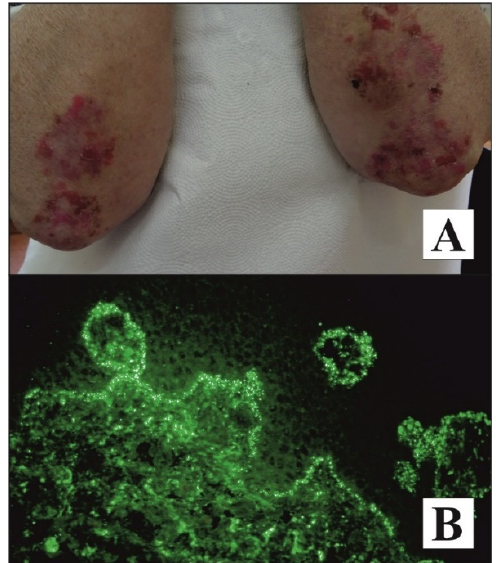
Figure 1. Noteworthy patients with DH. A pruritic, symmetrical rash composed of evolutionary lesions or blisters on an erythematous base located mainly on 1/3 proximal extensor surface of forearms in an elderly woman, having a daughter with mutilating rheumatoid arthritis, with DH developed after vaccination against influenza who showed an elevated level of anti-tTG IgA with ELISA and positive result of b-aIB for anti-npG IgA ( A ). Microgranular IgA deposits (++) at the tips of dermal papillae and along the dermal-epidermal junction revealed using direct immunofluorescence of perilesional skin visualized with short arc mercury lamp-operated microscopy in a middle-aged man with both DH and type 1 diabetes (DIF, original objective magnification ×40) ( B ). Demographic data and detailed characteristics of patients participating in the study are presented in Table